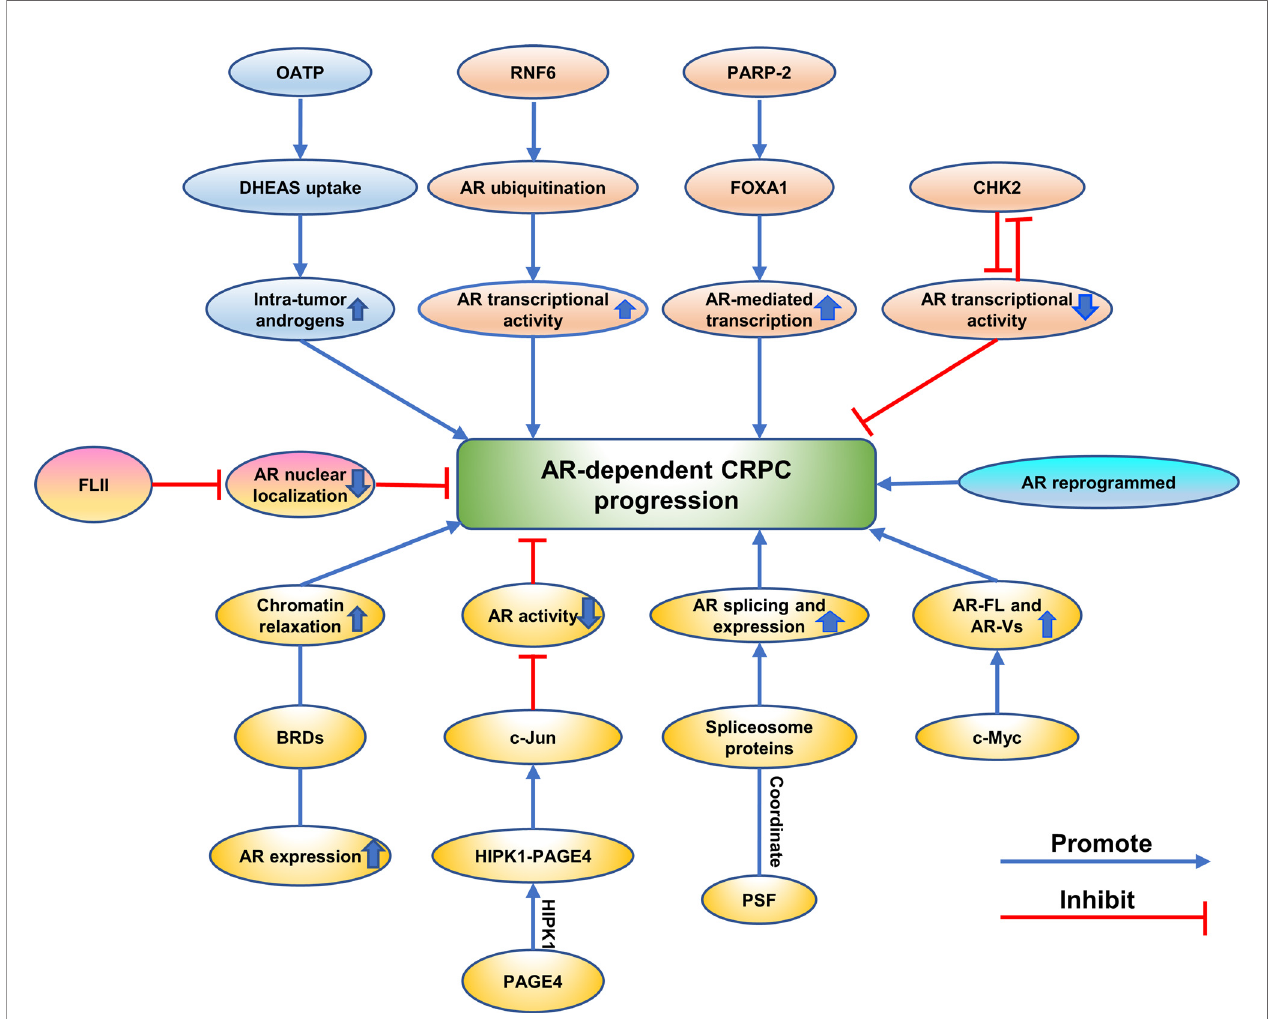
FIGURE 4 | Emerging proteins mediate CRPC progression via AR-dependent way. The different mechanisms are showing as different